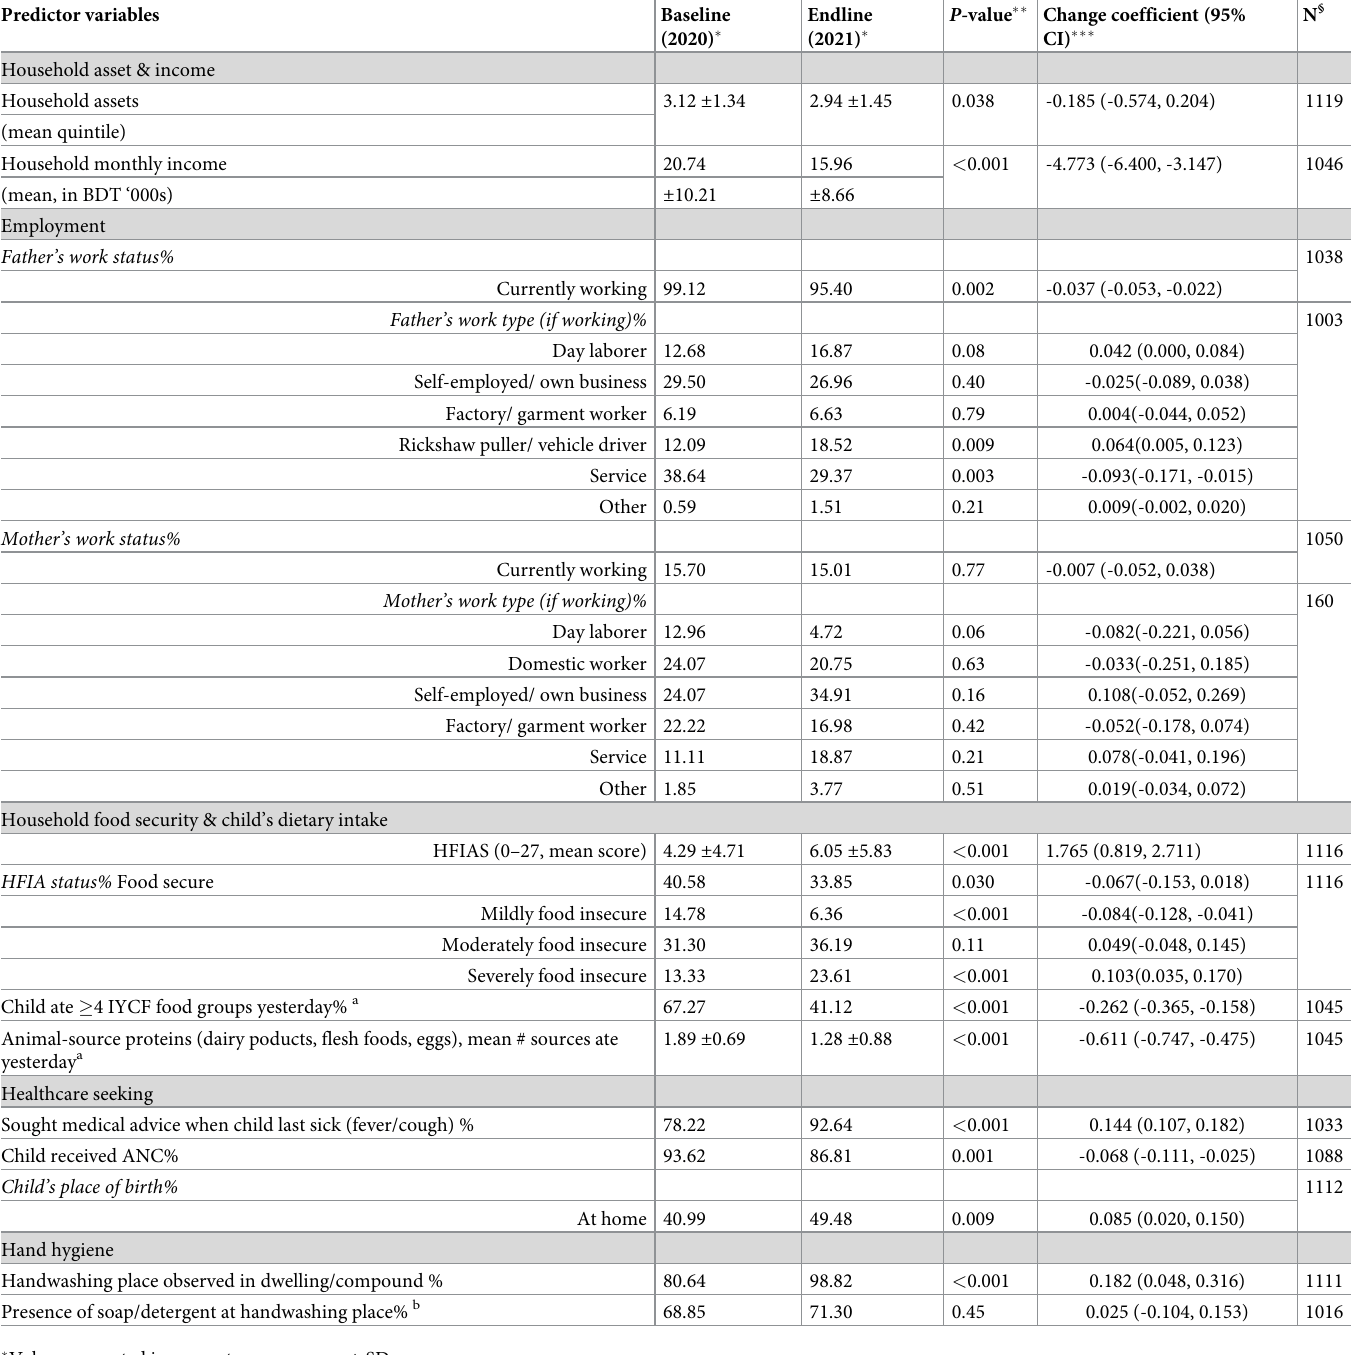
Table 2. Estimated change in underlying predictors of childhood undernutrition between baseline and